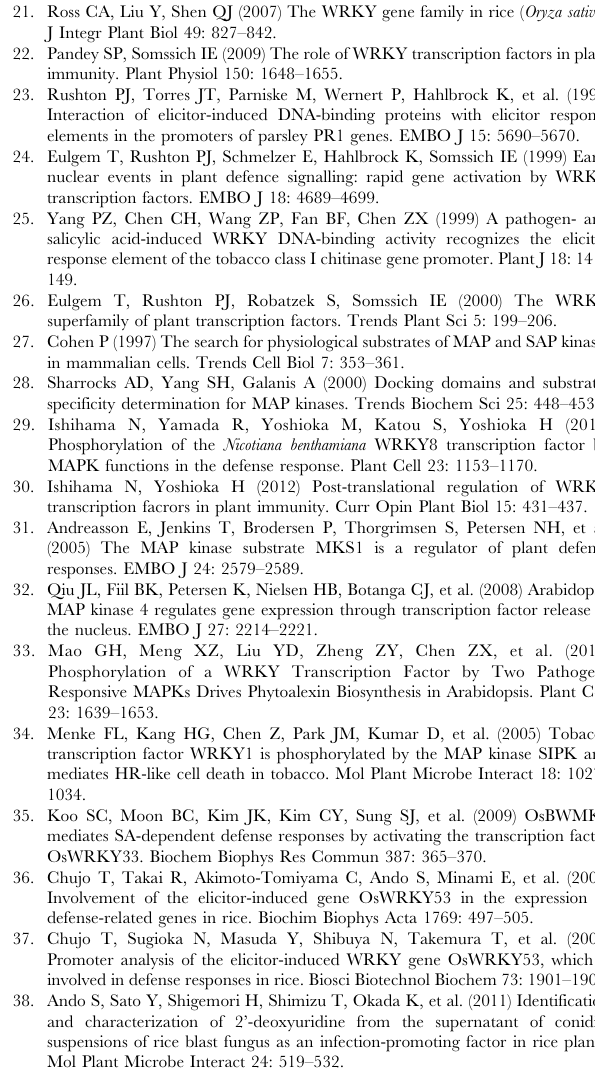
Table S4 Primers used for quantitative genomic PCR analysis. Table S5 List of genes whose expression is significantly altered in OsWRKY53SD -overexpressing rice